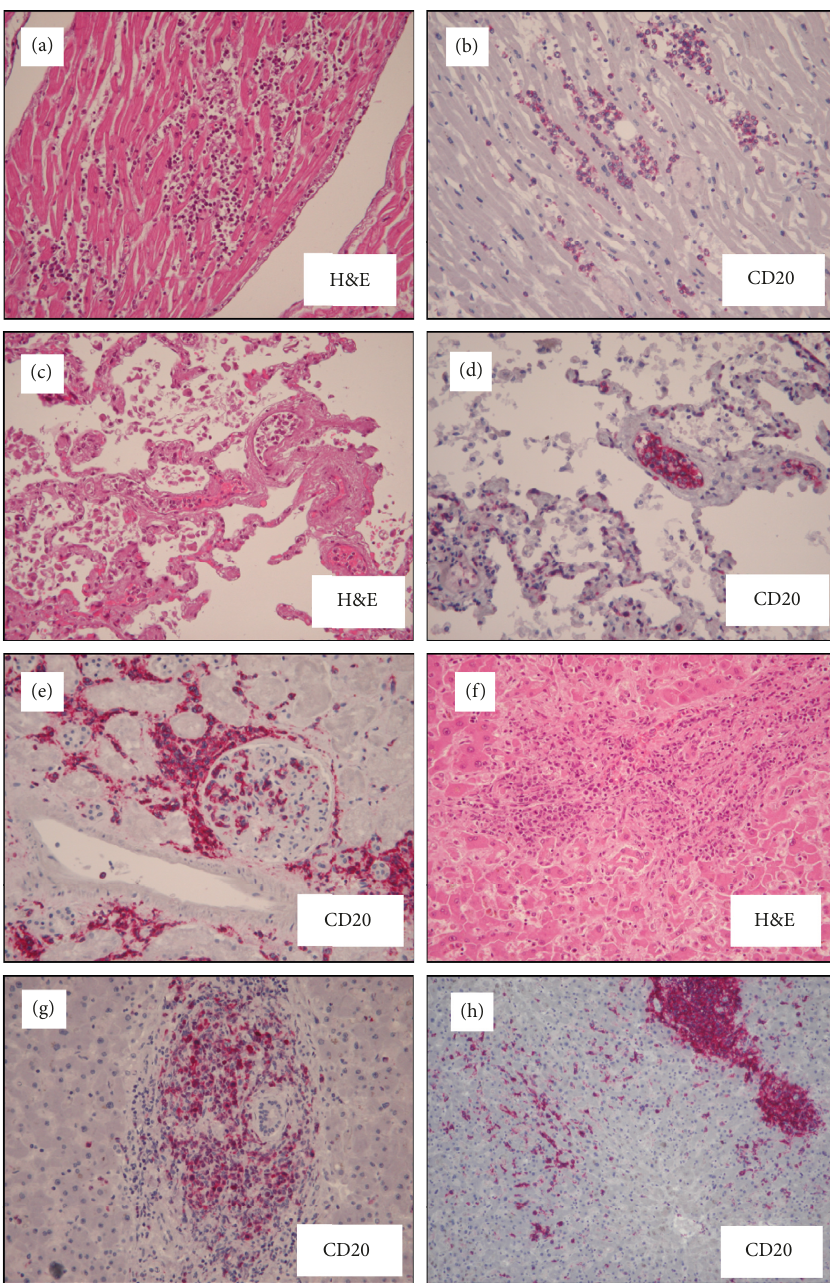
Figure 1: Microscopic appearance of IVLBCL infiltrating heart (a, b), lung (c, d), kidney (e), and liver (f and g) portal localization; (h) sinusoidal localization). H&E � hematoxylin and